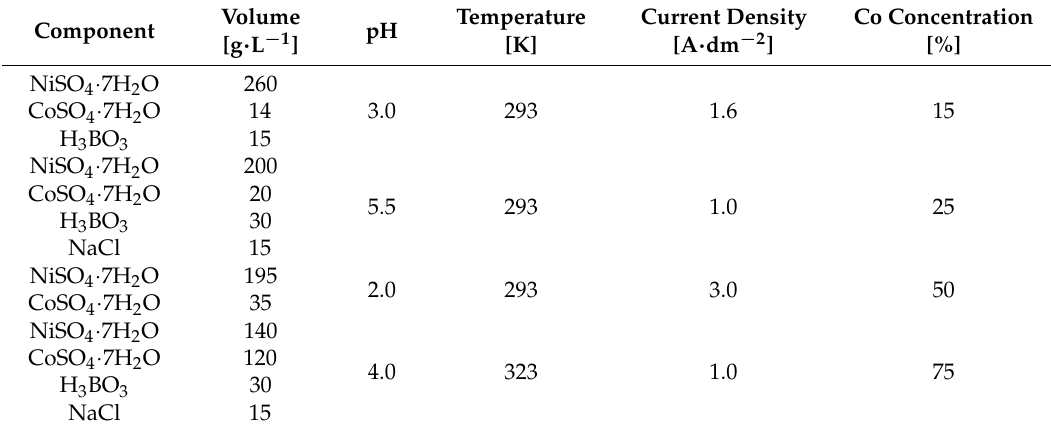
Table 2. Composition of the mixture applied for catalyst deposition (Ni–Co alloy) on the copper mesh. Component